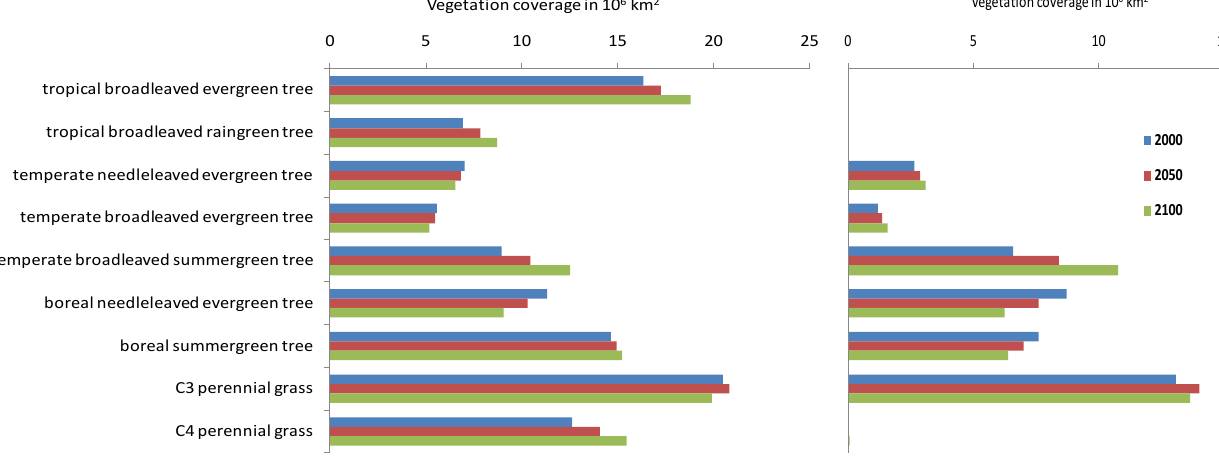
Figure 1. Global (left) and northern mid-latitude (30-60 o N) areal coverage of various vegetation Fig. 1. Global (left) and northern mid-latitude (30-60 ◦ N) areal coverage of various vegetation types for 2000s, 2050s, and 2100s simulated types for 2000s, 2050s, and 2100s simulated with the LPJ model. with the LPJ model. Temperate broadleaved summergreen trees Boreal needleleaved evergreen trees Isoprene emissions Ozone dry deposition